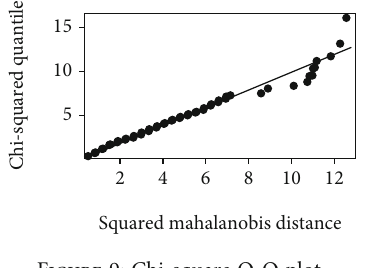
Figure 9: Chi-square Q-Q plot. Table 1: Pairwise comparison test.